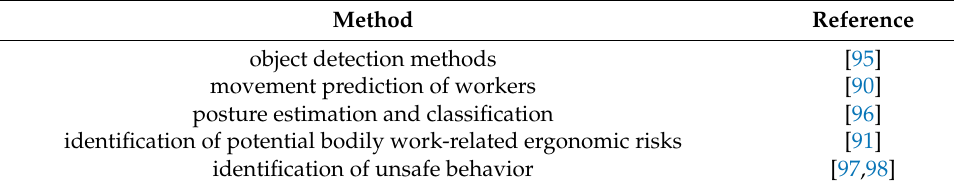
Figure 6. The annual publication trend of sensing and warning-based technology [9]. Table 4. Methods of vision-based sensing technologies in hard hats